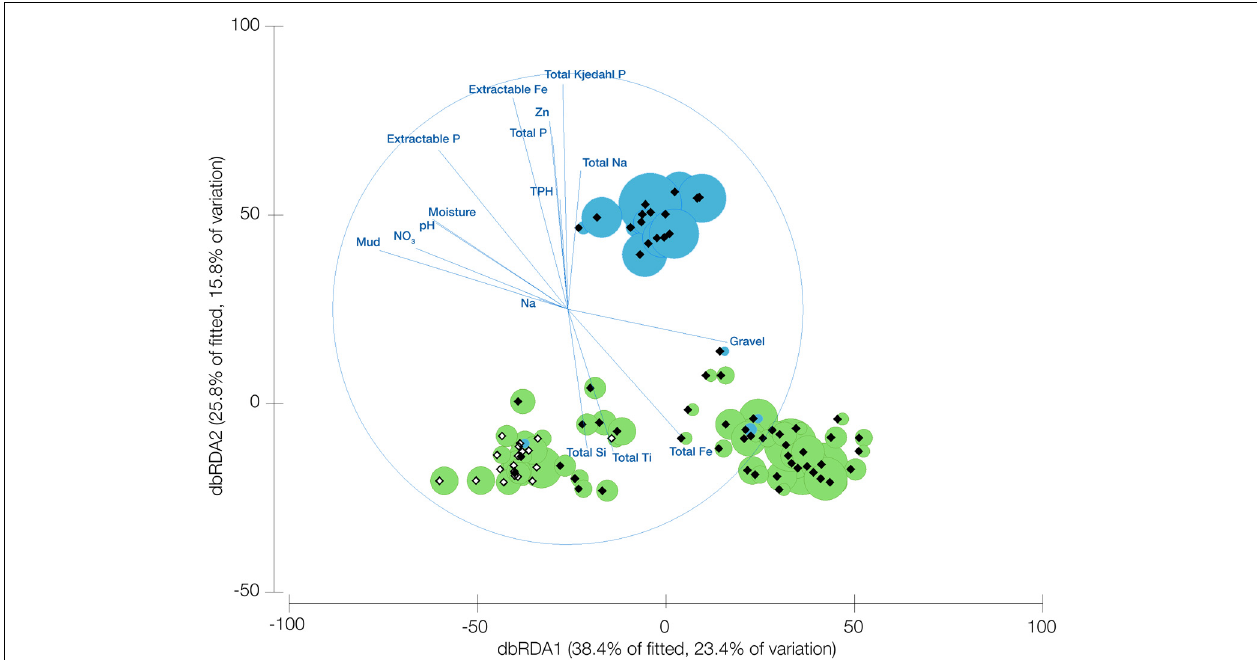
FIGURE 2 | Distance based redundancy analysis of UniFrac dissimilarity scores for samples where bacteria from the candidate division TM7 are present. Overlayed are vectors representing the correlation of edaphic